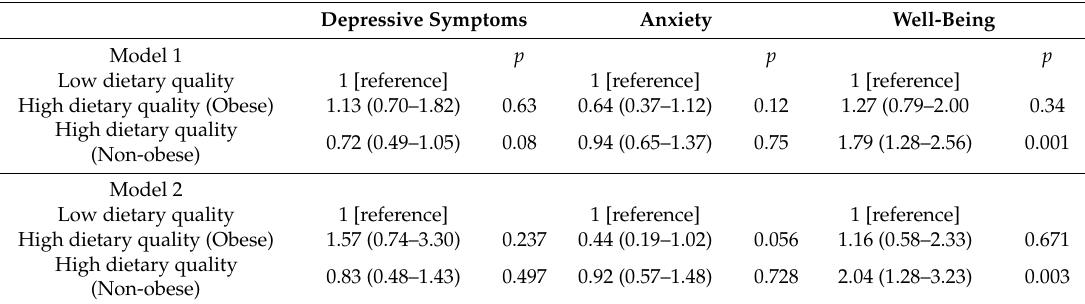
Table 4. Odds ratios (95% CI) for mental health outcomes according to dietary quality stratified by BMI